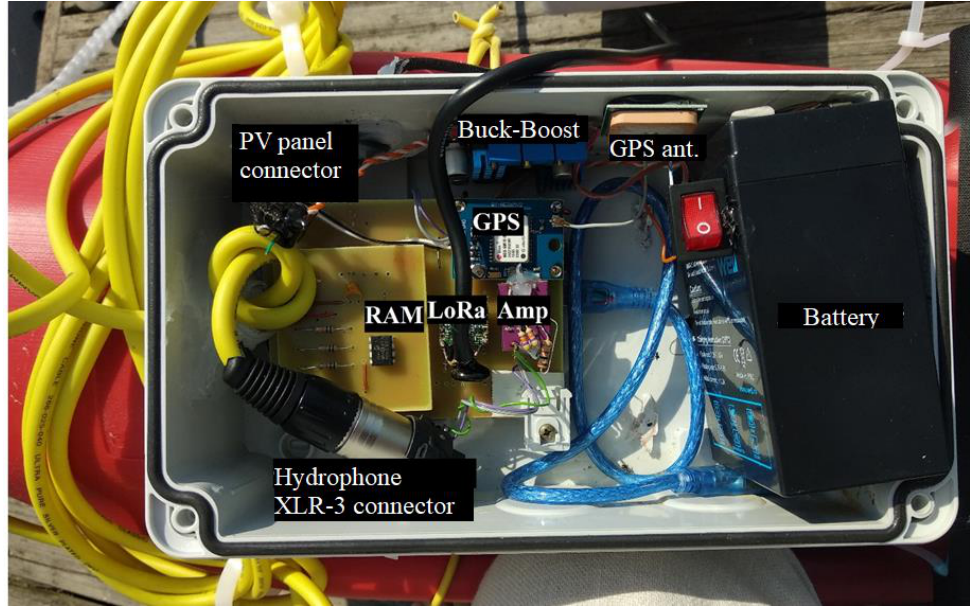
Figure 4. Electronic blocks on board a beacon.